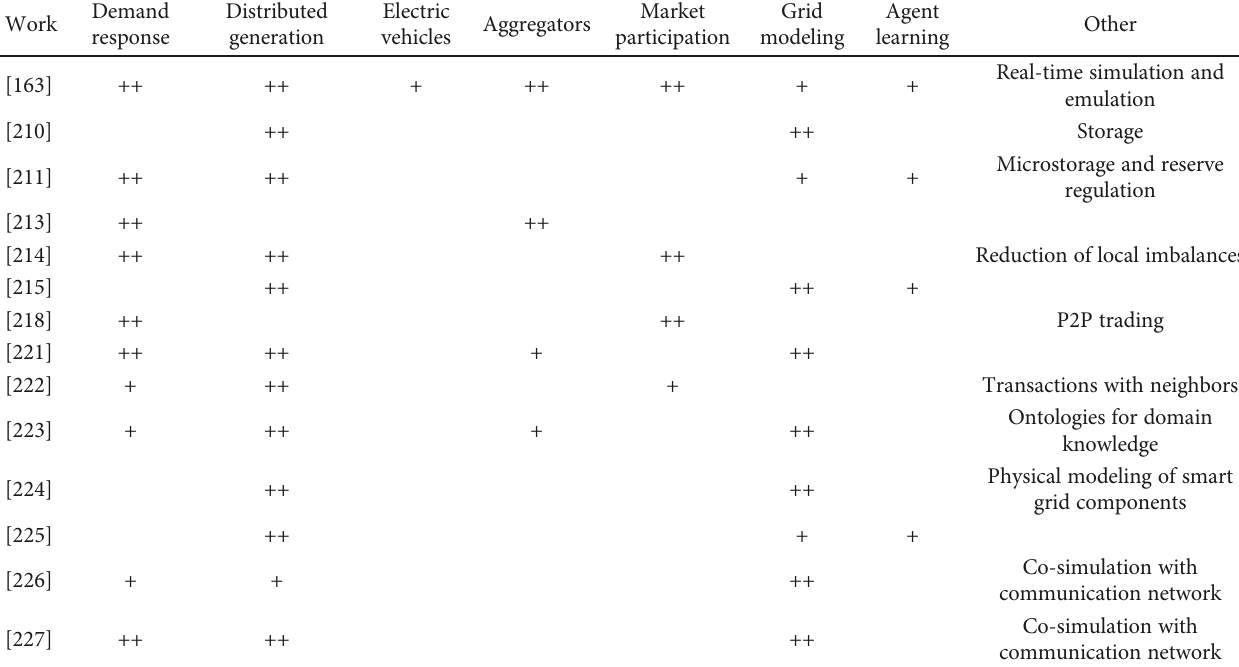
Table 11: Comparison of the main characteristics of some of the most relevant microgrid and smart grid simulators.